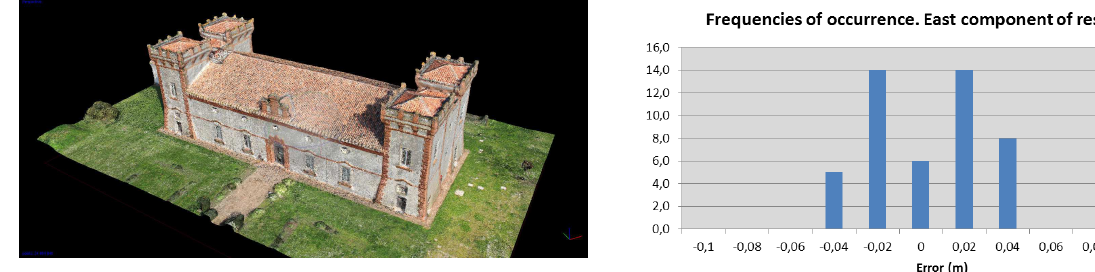
Figure 18. Front view of the final model.